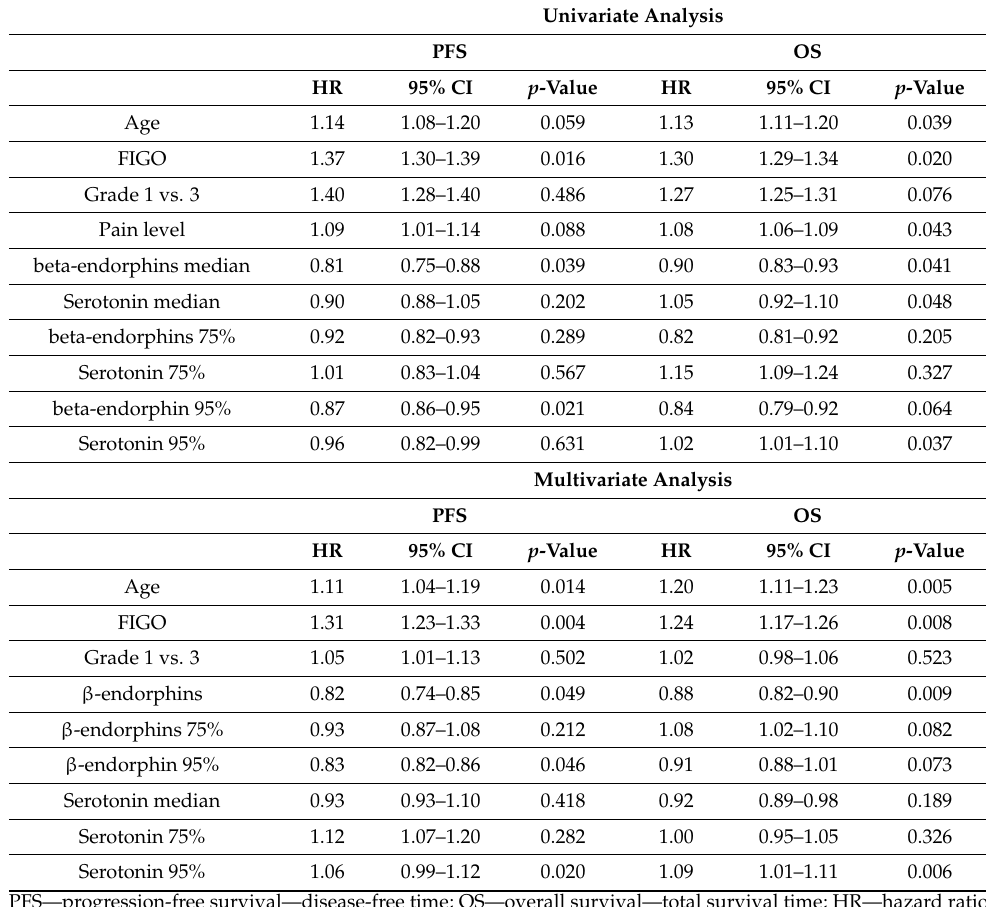
Table 12. Survival analysis of the study group- women with ovarian cancer (III–IV stage according to